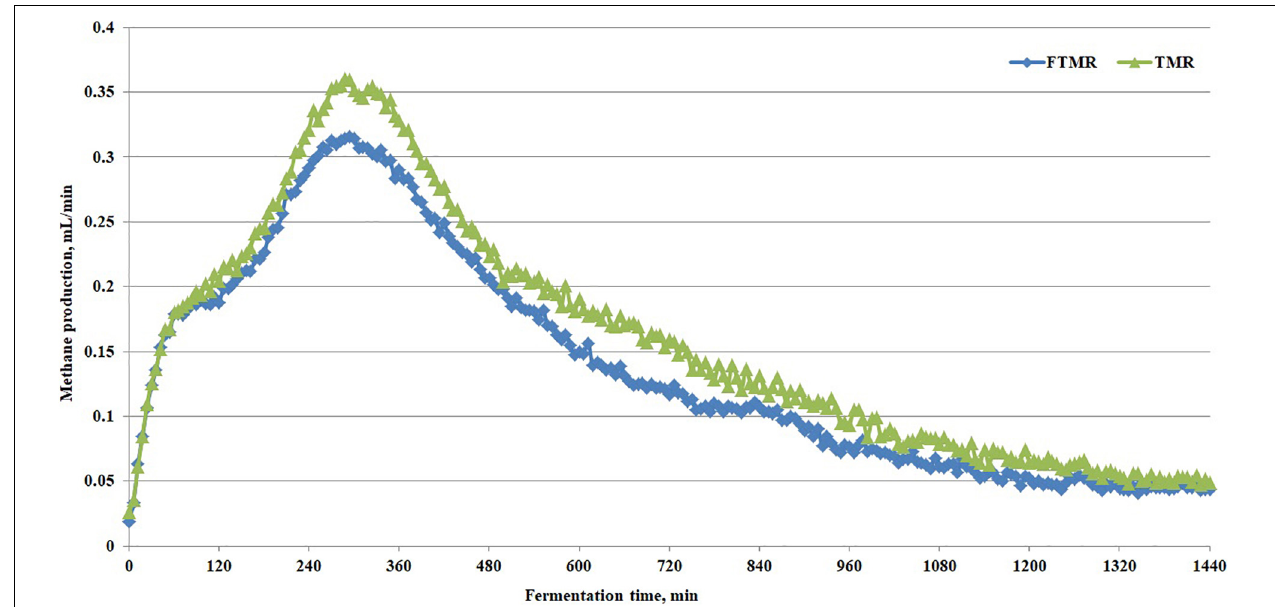
FIGURE 3 | Methane production curve in vitro with fermented or non-fermented TMR.